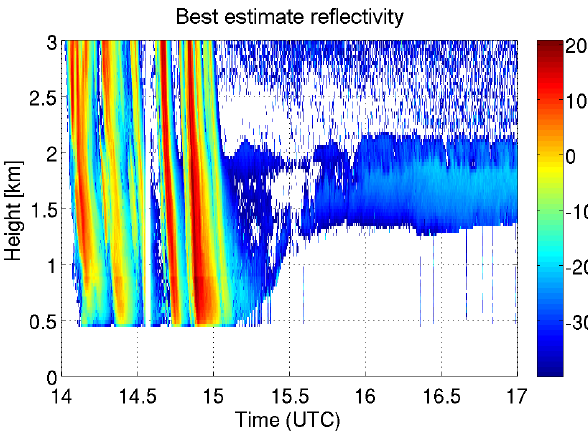
Figure 10. Best-estimate radar reflectivity (bottom) from the Ka-band ARM zenith-pointing Radar Active Remote Sensing of CLouds (ARSCL) product for 5 June